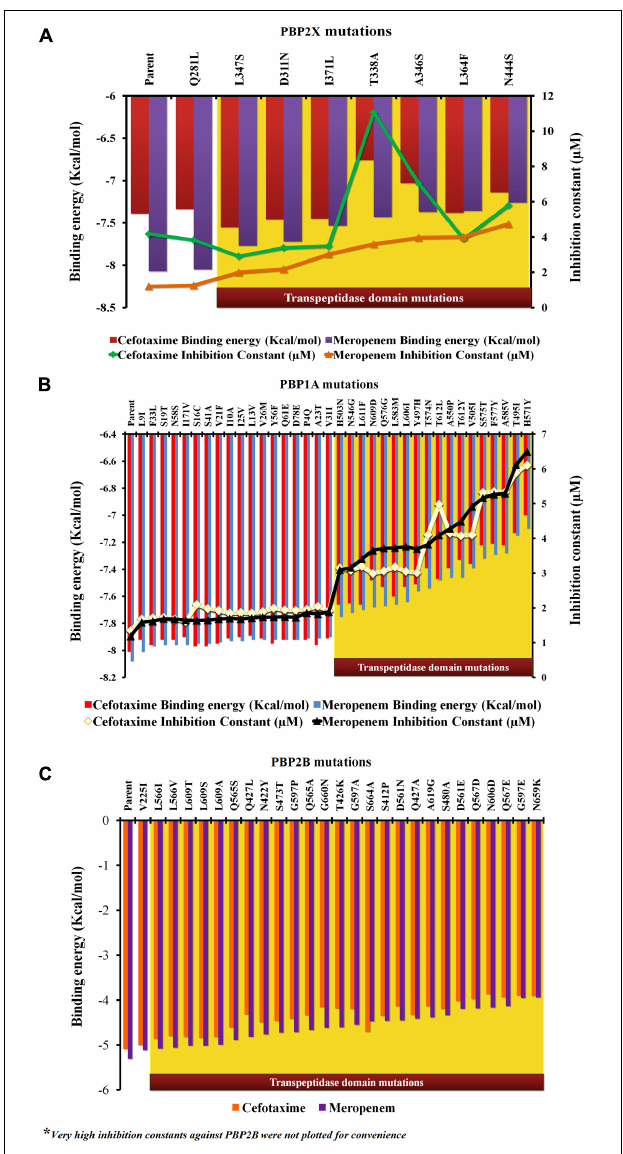
FIGURE 3 | The relative impact of individual mutations on the binding energies and inhibition constants of cefotaxime and meropenem